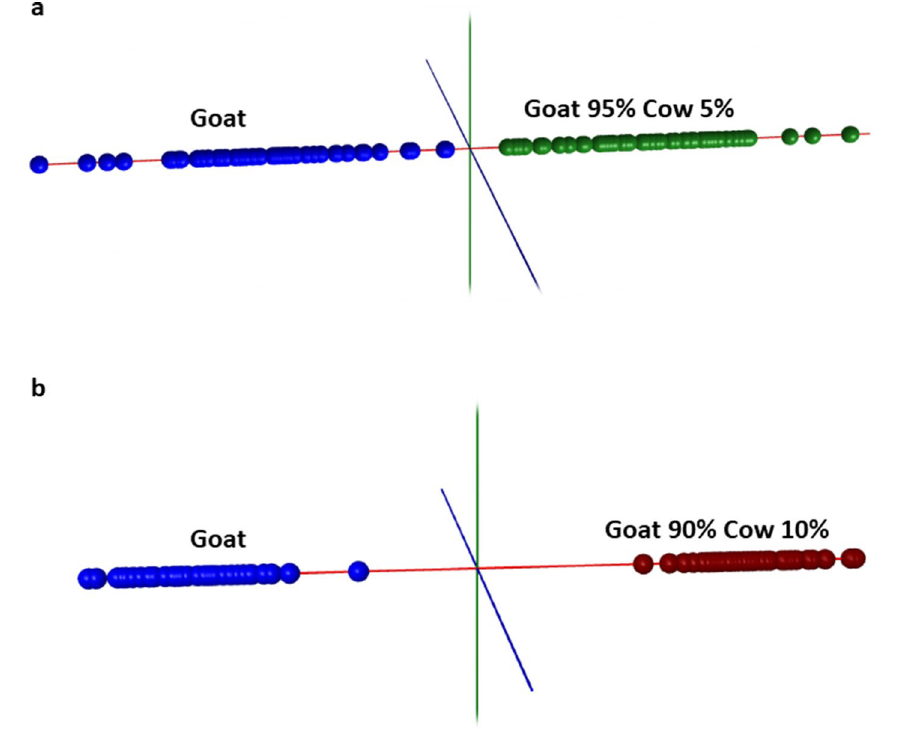
Figure 3. Linear Discriminant Analysis (LDA) obtained with Abstract Model Builder (AMX) showing full separation of all 100% goat milk samples (n = 50) from all goat milk samples adulterated with 5% cow milk (n = 54) ( a ) and from all goat milk samples adulterated with 10% cow milk (n = 48) ( b ).